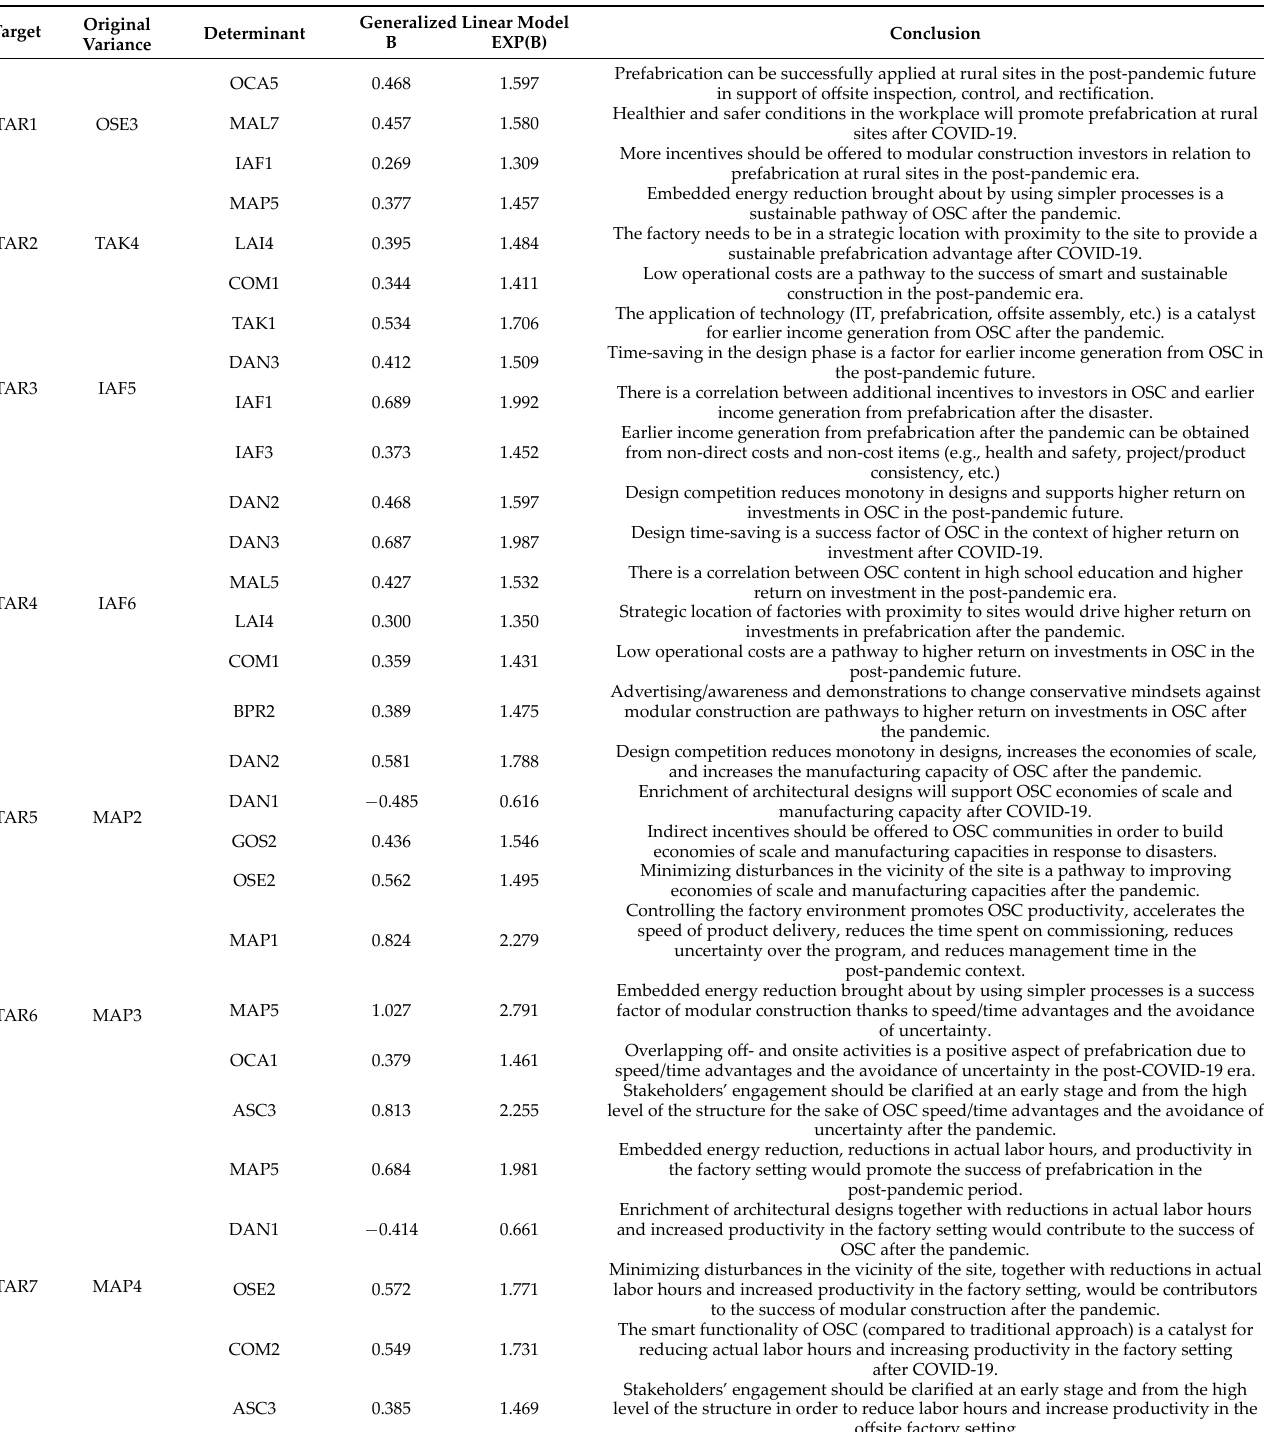
Table 1. Significant correlations between predictors and OSC success after the